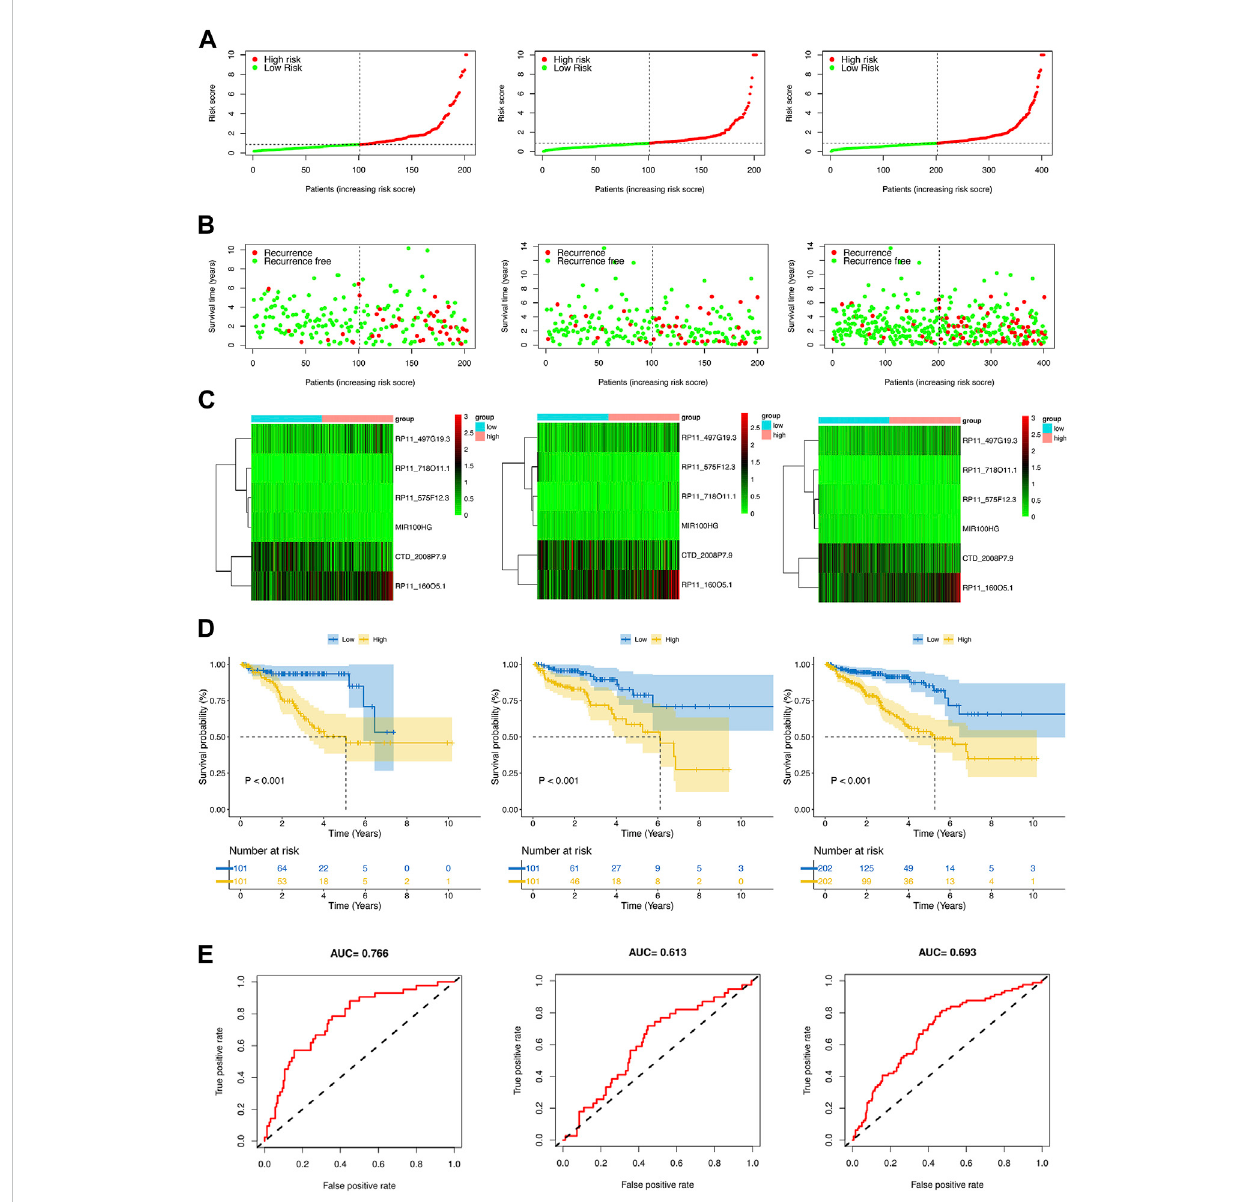
FIGURE 4 Prognosis value of the risk model in different sets. (A) The risk score distribution of PCa patients based on crlncRNAs in the training, test, and whole sets, respectively. (B) BCRFS and BCR status between the low- and high-risk groups in the training, test, and whole sets, respectively. (C) The heatmap of six crlncRNAs expression in the training, test, and whole sets, respectively. (D) Kaplan-Meier survival analysis of BCRFS of patients in the training, test, and whole sets, respectively. (E) ROC curve analysis of the risk model in the training, test, and whole sets,